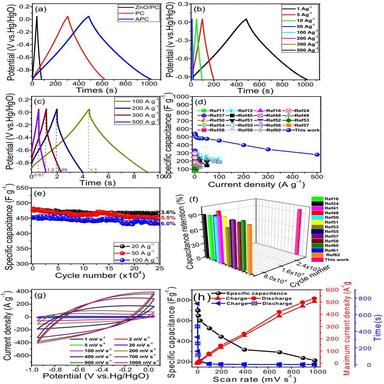
(a) GCD curves of ZnO/PC, PC and APC electrodes at 1 A g1 , (b,c) GCD curves of APC eletrode at different CDs from 1 to 500 A g1 , (d) relationship between the SC and different CD of APC electrode and the reported MOFs derived carbons, (e) long-term GCD cyclic tests of APC electrode at various CDs of 20, 50, and 100 A g1 for 250,000 cycles, (f) comparison of cyclic performance of APC electrode and the reported carbons derived from MOFs, (g) CV curves of APC electrode at different scan rates from 1 to 1000 m